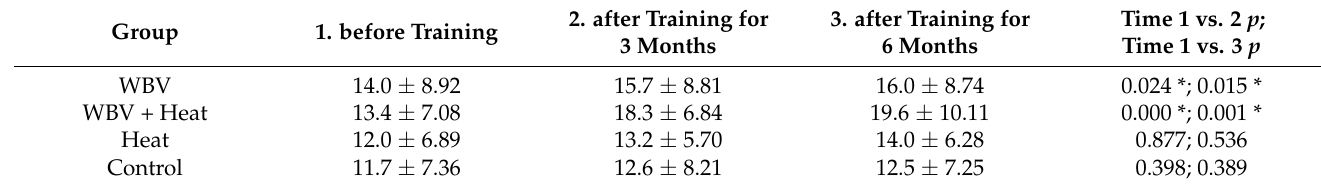
Figure 4. Flexibility in six months with different groups. Table 2. Comparison of the Training Effect on Flexibility in Six Months.